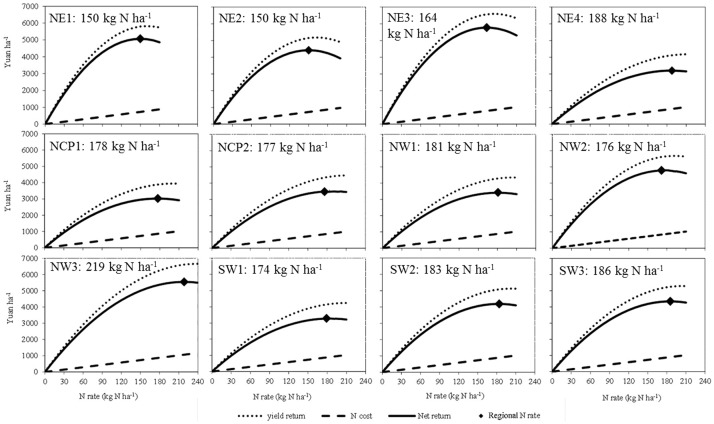
Maize grain yield and fertilizer economic components of calculated net return across N rates using the regional N management approach indicated at the 2.05 price ratio (N price 4.87 yuan kg−1 and maize price 2.37 yuan ha−1) in the 12 agroecological subregions.In total, 1,726 N responses trials were used to estimate the regional N rate. The net return is the increase in yield times the grain price at a particular N rate, minus the cost of that amount of N fertilizer. The maximum return is the N rate at which the net return is greatest.